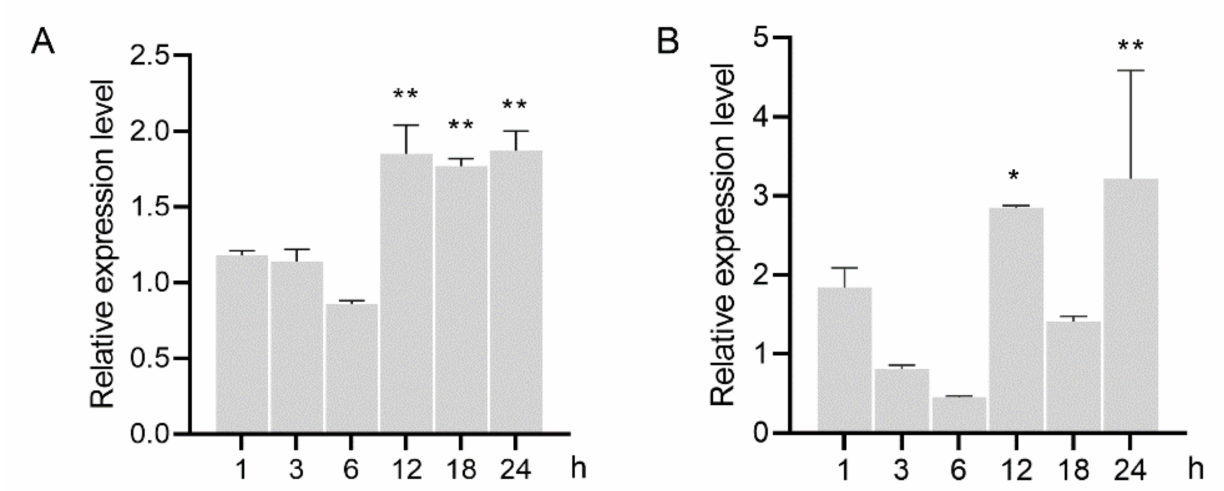
Figure 6. Relative mRNA expression levels of GH16s in A. besseyi feeding on Botrytis cinerea . ( A ) AbGH16-1; ( B ) AbGH16-2. The bars indicate the standard deviation of mean ( n = 3), asterisks on the bar indicate significant differences (*, p < 0.05; **, p < 0.01) between 0 h and the corresponding time point by Student’s t